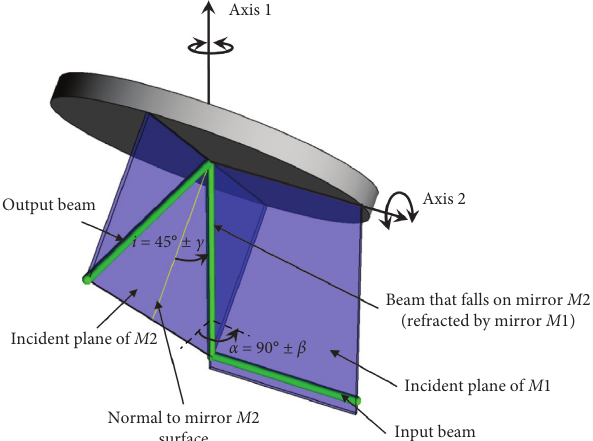
Figure 5: The main axes of the displacement of the mirror M 2 of TSM.